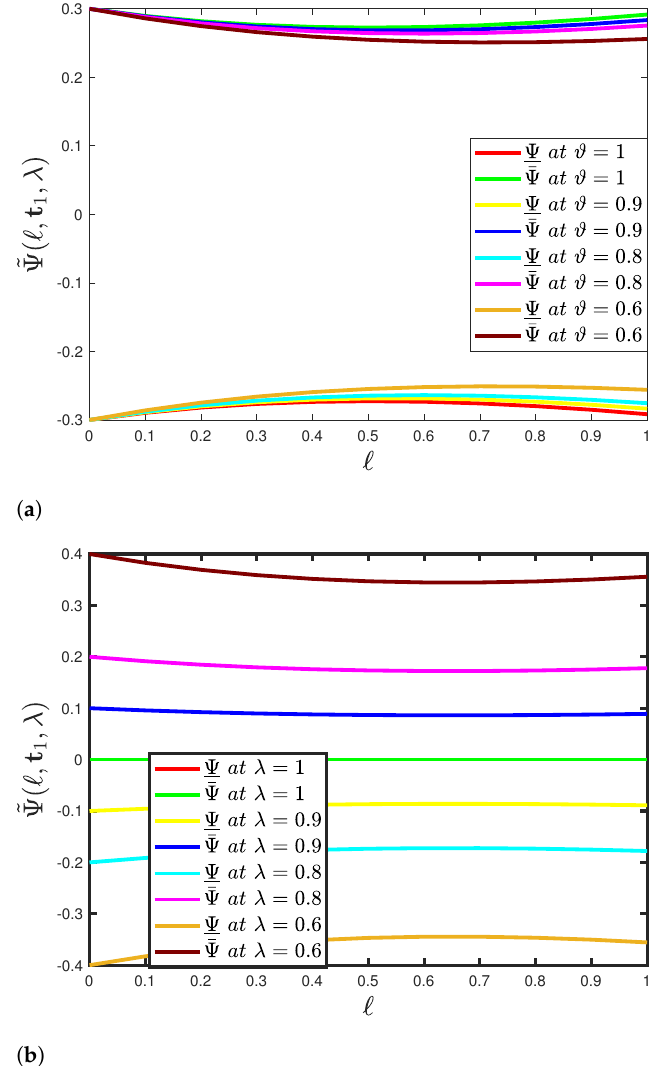
Figure 2. Two-dimensional simulation of ˜ Ψ ( (cid:96) , t 1 ; λ ) of Problem (1): ( a ) Ψ ( (cid:96) , t 1 ; λ ) and ¯ Ψ ( (cid:96) , t 1 ; λ ) when fuzzy CFD is considered to have an uncertainty parameter λ ∈ [ 0,1 ] and t 1 = 0.7; and ( b ) Ψ ( (cid:96) , t ) and ¯ Ψ ( (cid:96) , t ) when fuzzy CFD is considered to have a fractional order ϑ = 0.7 and 1 ; λ 1 ; λ t 1 =